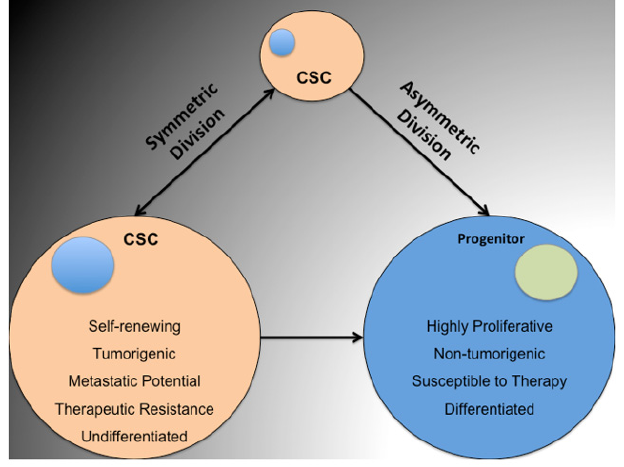
Figure 1. Diagram depicting the lineage of cells produced by cancer stem cells and the phenotypic differences between the cell types they produce.